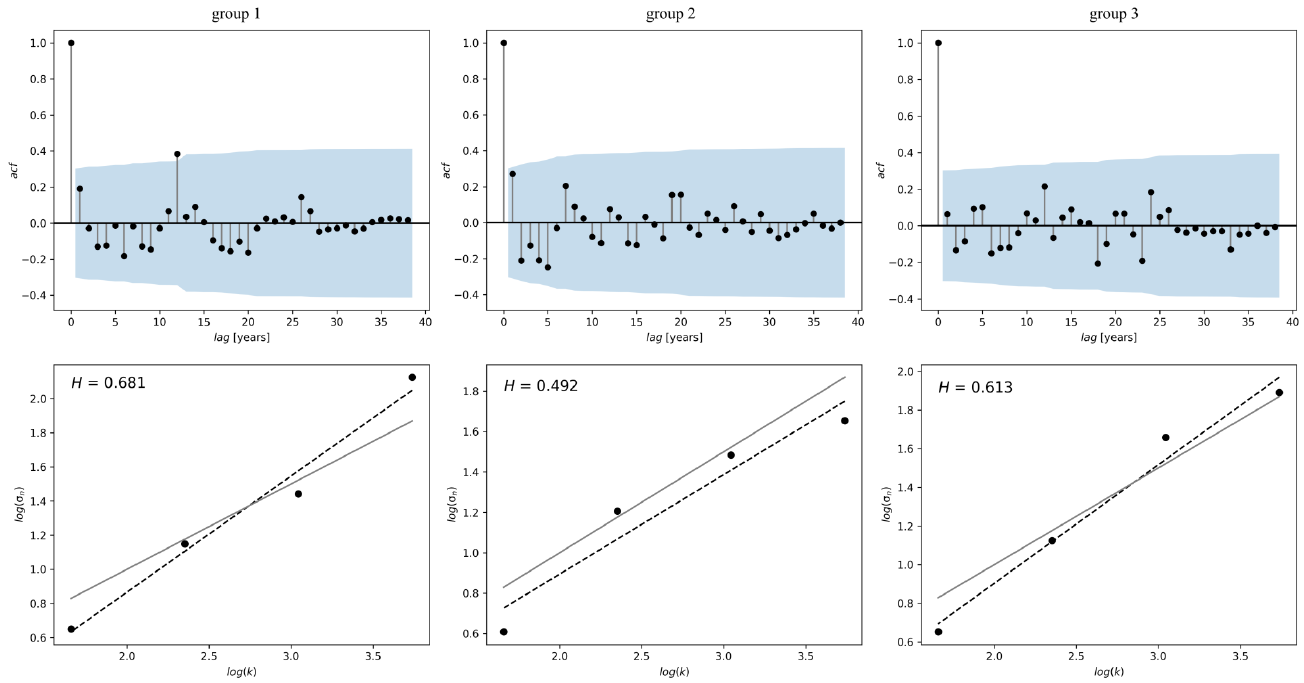
Figure 2. Examples of autocorrelation functions (ACF) (top row) and climacograms for Hurst exponent (bottom row) for the same, randomly selected nodes in each defined cluster; solid line – white noise process, dash line – Hurst-Kolmogorov process.